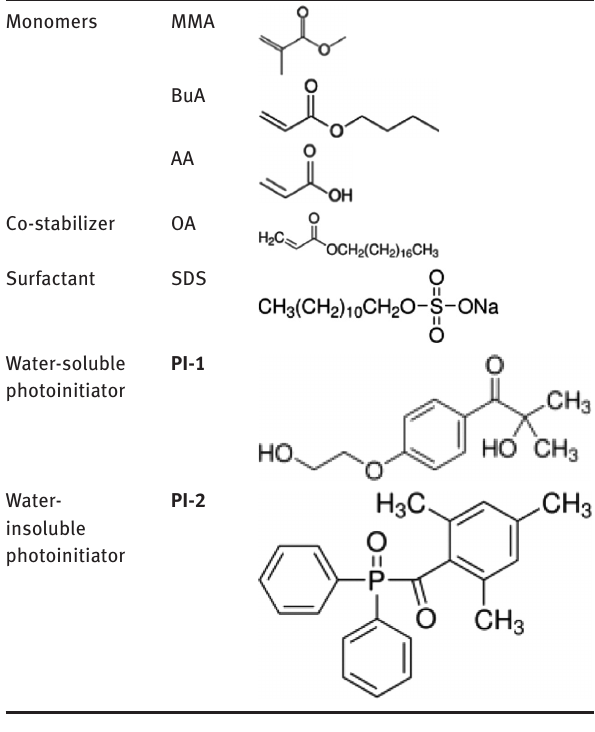
Table 1 Chemical structures of the components of the acrylate miniemulsion.